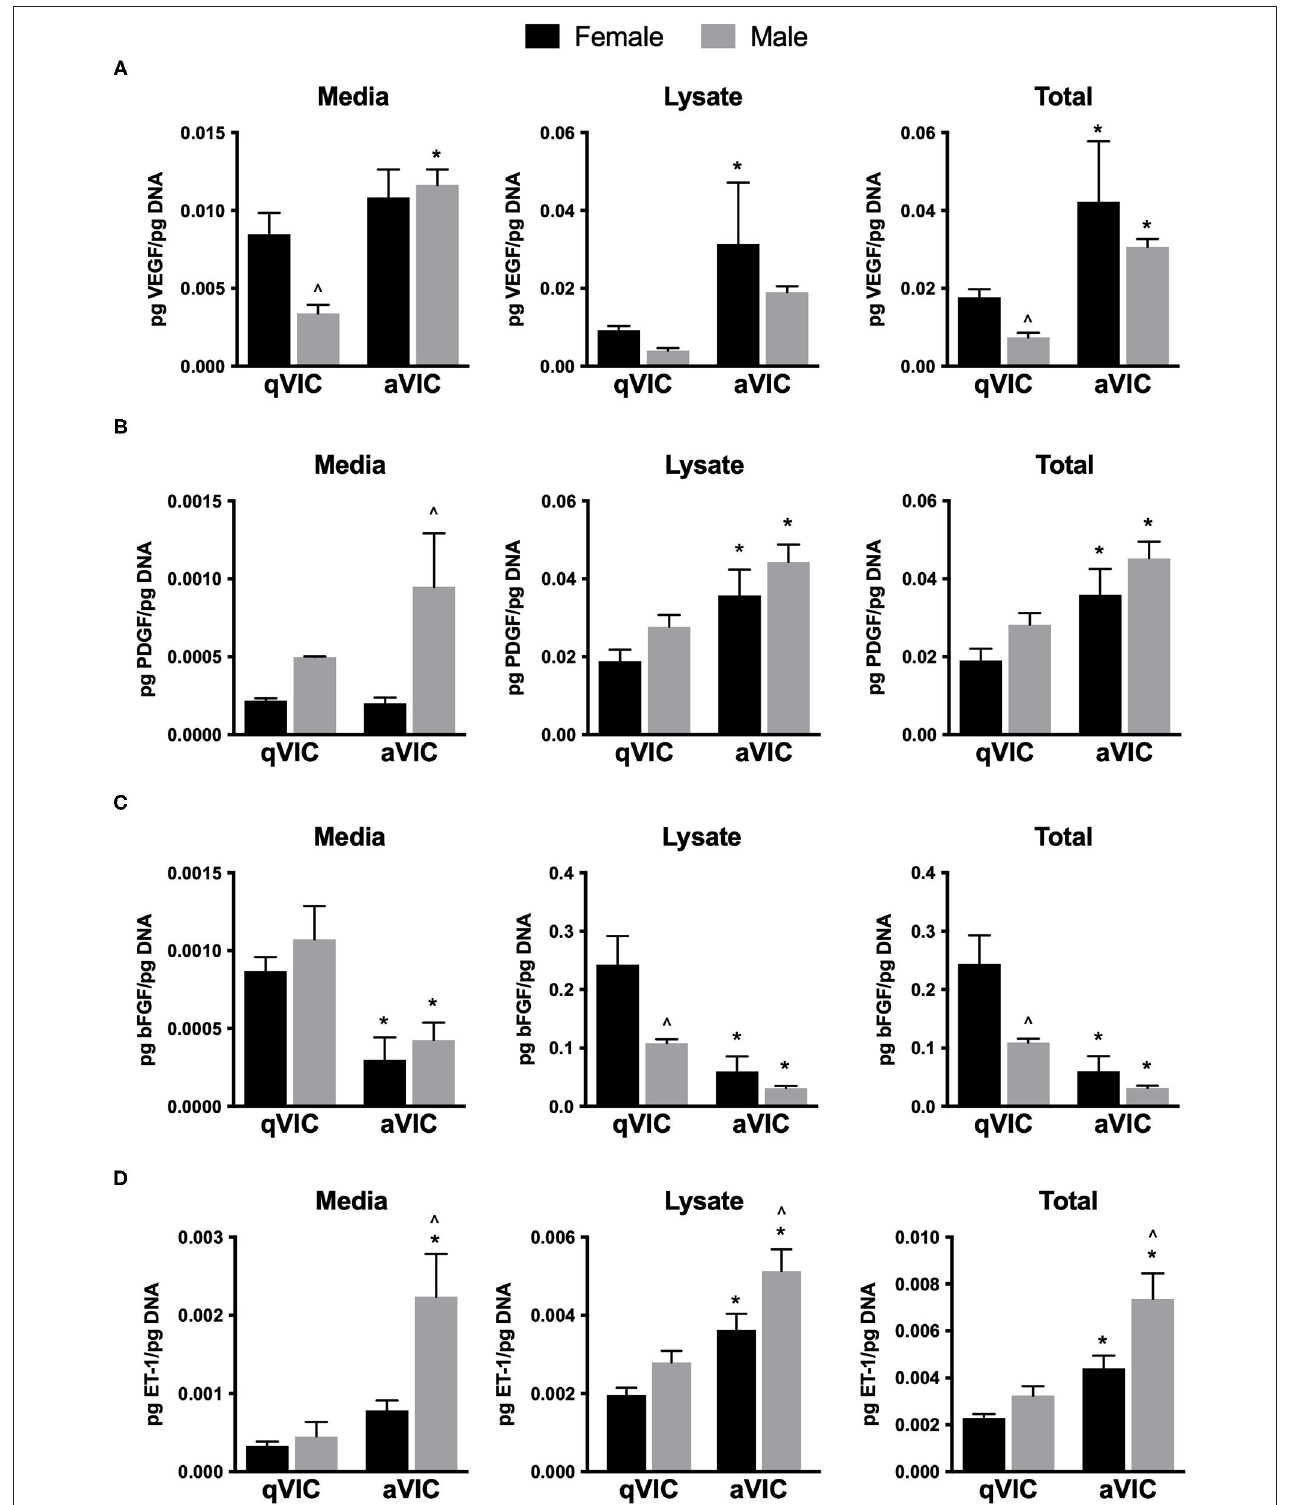
FIGURE 1 | Production of pro-angiogenic factors by male and female qVICs and aVICs. (A) vascular endothelial growth factor (VEGF), (B) platelet derived growth factor-A (PDGF), (C) basic fibroblast growth factor (bFGF), and (D) endothelin-1 (ET-1). * p < 0.05 vs. sex-matched qVIC level; ∧ p < 0.05 vs. female VIC of same phenotype by two-way ANOVA with Tukey’s post hoc test. N = 3 pigs per sex, n = 3 wells per condition.